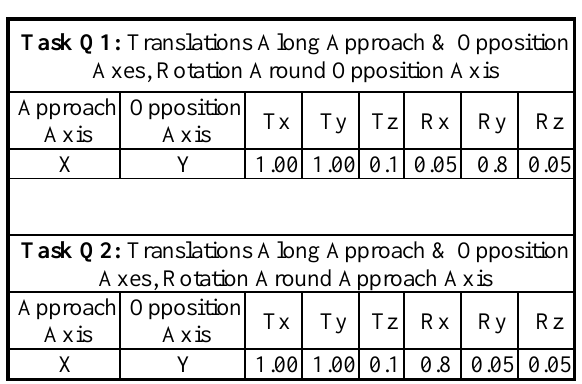
Table 1 Task Decompositions into Wrench